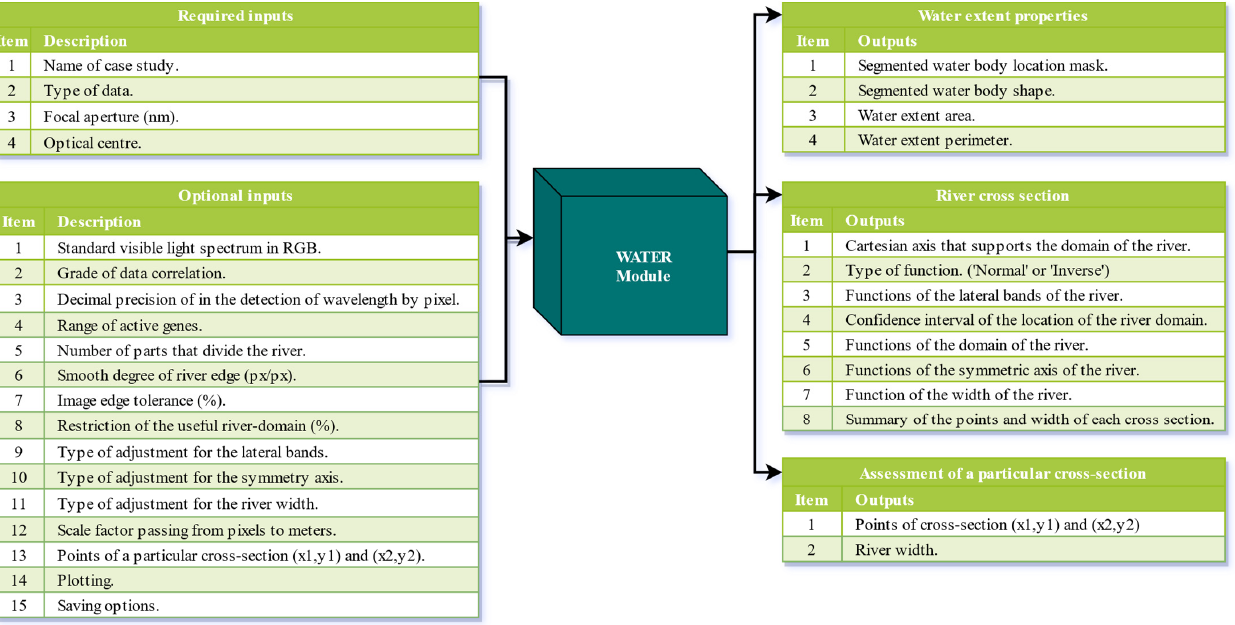
Figure 3. WATER overview with required and optional inputs as well outputs. The reader is re- ferred to Supplementary Material A and B as well as codes for more information regarding the al- gorithms involved.